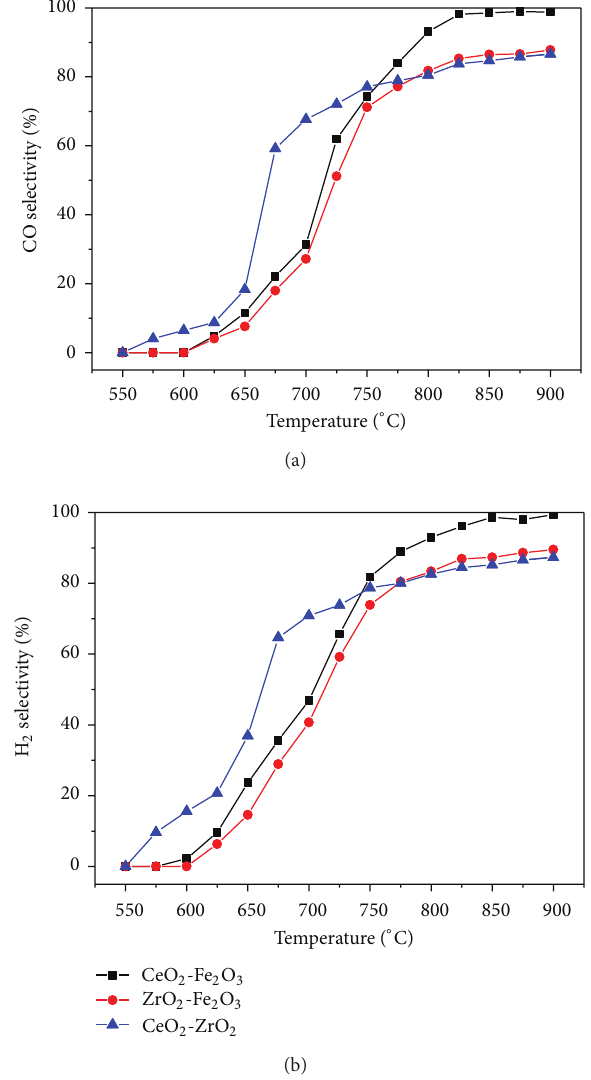
Figure 4: CO and H 2 selectivity as a function of reaction tem- perature over CeO 2 -Fe 2 O 3 , CeO 2 -ZrO 2 , and ZrO 2 -Fe 2 O 3 oxygen carriers